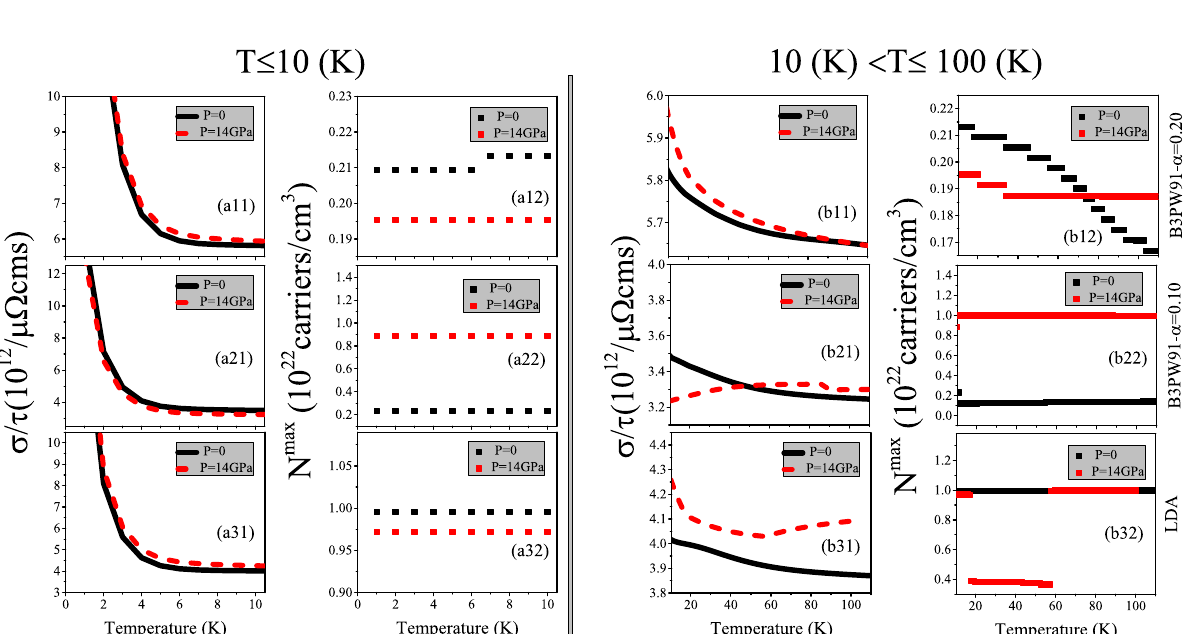
Figure 3. Maximum values of spin up electrical conductivity per relaxation time ( τ ), i.e., σ max /τ of electron/ hole doped CeIn 3 versus temperature for ( ai1 ) T ≤ 10 K and ( bi1 ) 10 K < T ≤ 100 K calculated using B3PW91 with α = 0.20, 0.10 and LDA for the P = 0 and 14 GPa pressures. Doping levels related to the σ max /τ are displayed in ( ai2 ) and ( bi2 ) panels for T ≤ 10 K and 10 K < T ≤ 100 K, respectively. The i-index varies from 1 to 3. In the AFM phase, spin down results are the same as spin up